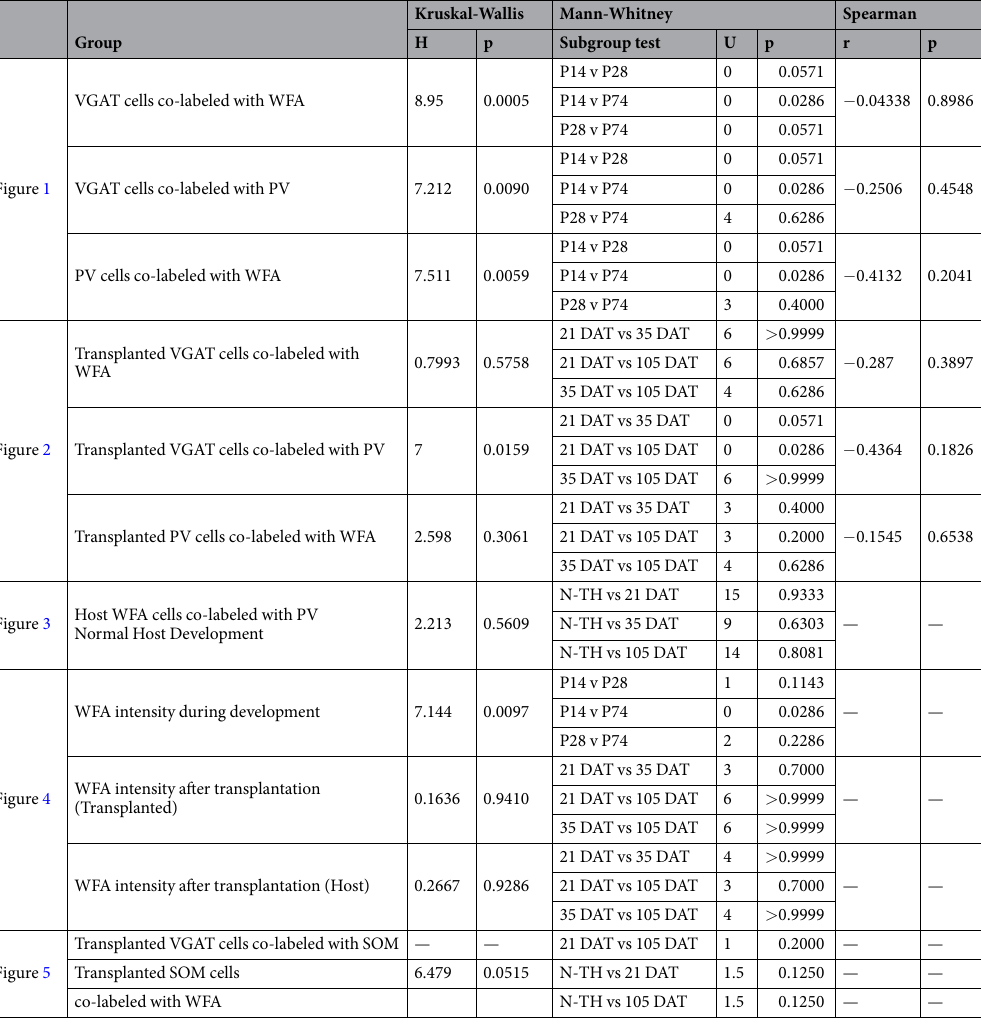
under the control of the Vesicular GABA Transporter (VGAT) promoter (VGAT-ires-Cre, JAX 028862). Wild-type C57BL/6J mice (JAX 000664) were used as recipients for transplantation. Intrinsic Signal Imaging.